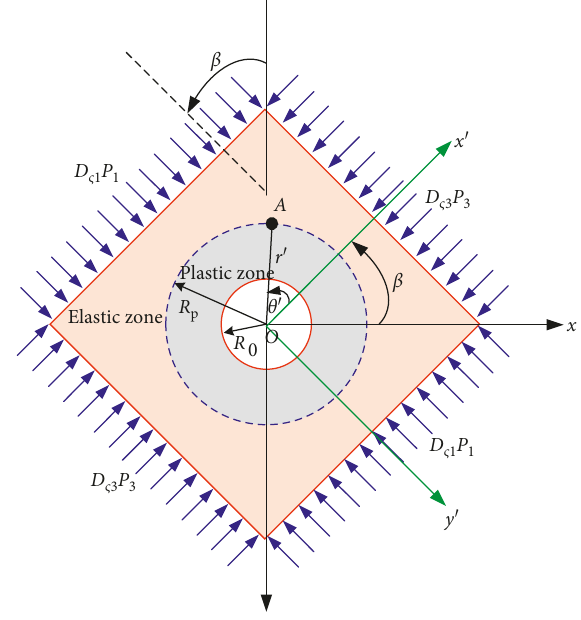
Figure 4: Mechanical model of the roadway under deflection of the principal stress